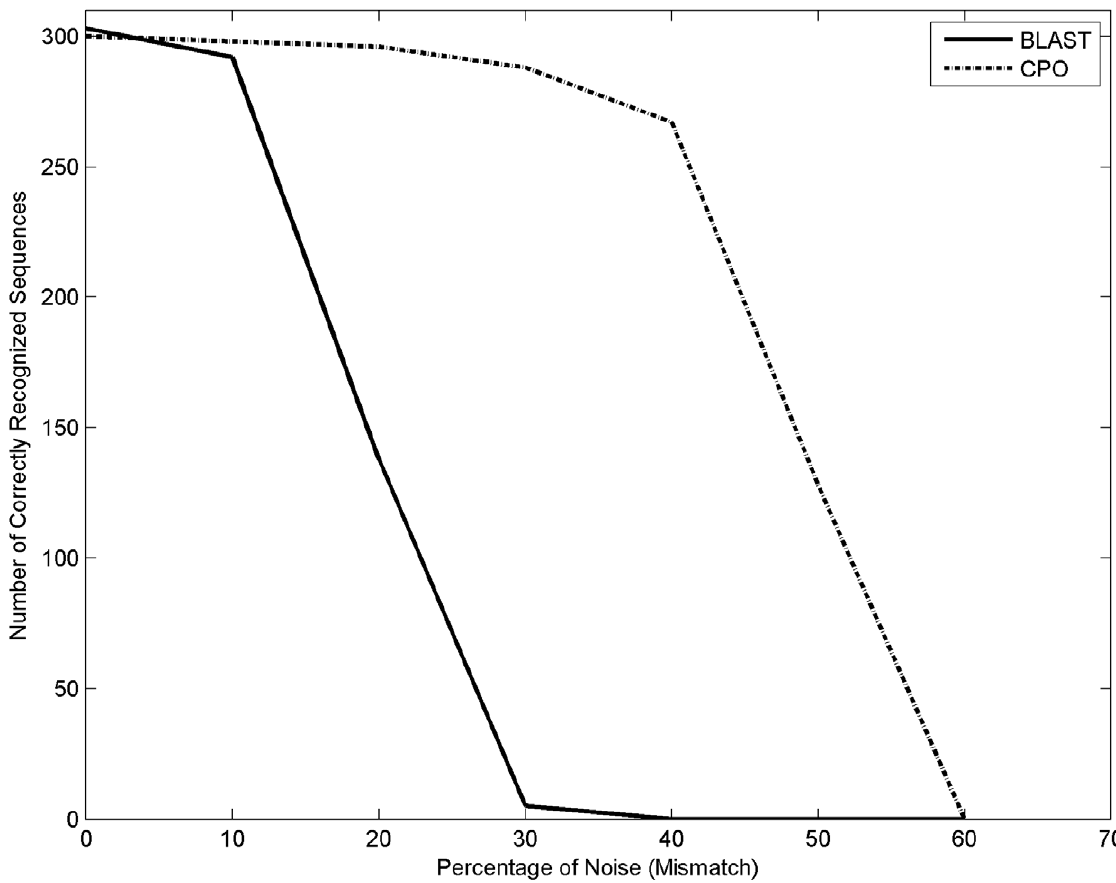
Figure 10. Sensitivity and mutation level. The sensitivity of BLAST decays faster than the sensitivity of the correlation, when the percentage of mutation increases. The latter recognizes similarity with more than 40% of mutated pairs.